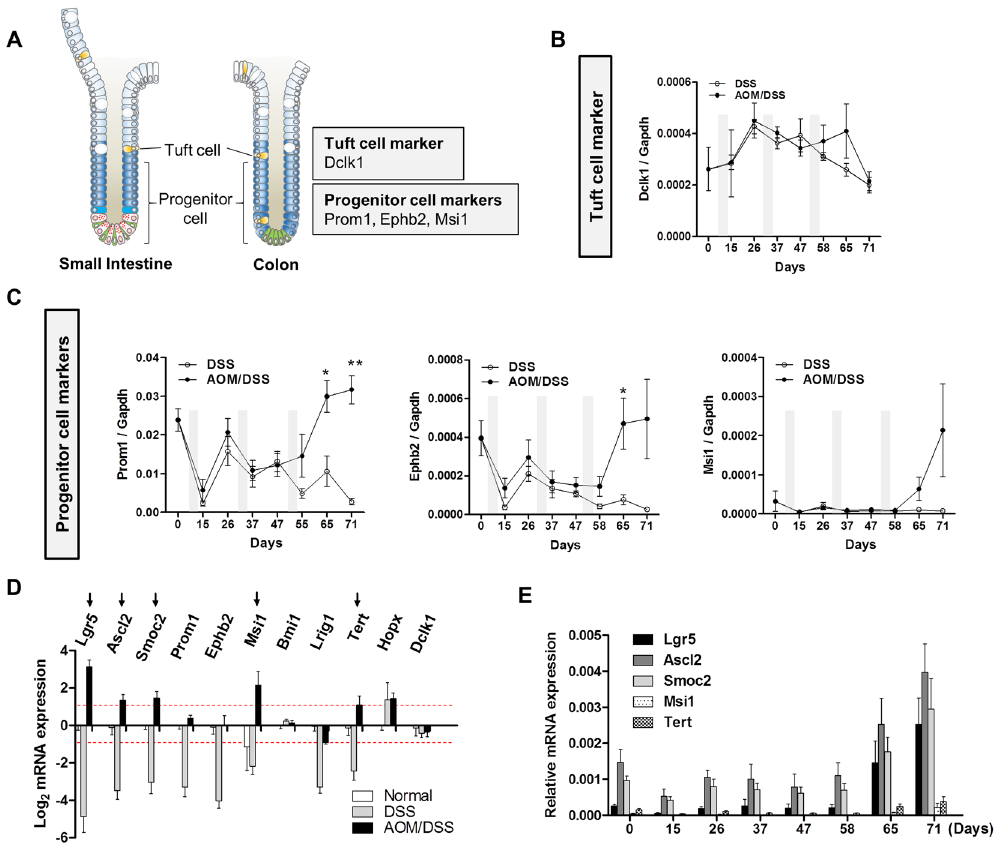
Figure 2. Expression of tuft cell and progenitor cell markers in colitis-associated carcinogenesis (CAC). ( A ) Diagram of tuft cell and progenitor cell markers in the crypt. ( B and C ) Real-time PCR analysis of tuft cell marker Dclk1 and progenitor cell markers Prom1, Ephb2, and Msi1. Data represent the means ± SEM. (DSS: n = 4, AOM/DSS: n = 5). ( D ) Relative mRNA expression of ISC markers in control and azoxymethane and dextran sodium sulfate (AOM/DSS) groups at day 71 compared to that in the normal colonic mucosa. Arrows indicate the markers that are expressed at two-fold higher levels in the AOM/DSS group and two-fold lower levels in the DSS group compared to expression in the normal colonic mucosa. Red dotted lines indicate the threshold. ( E ) Comparison of relative mRNA expression of five markers in CAC. SEM, standard error of the mean. * P < 0.05; ** P <